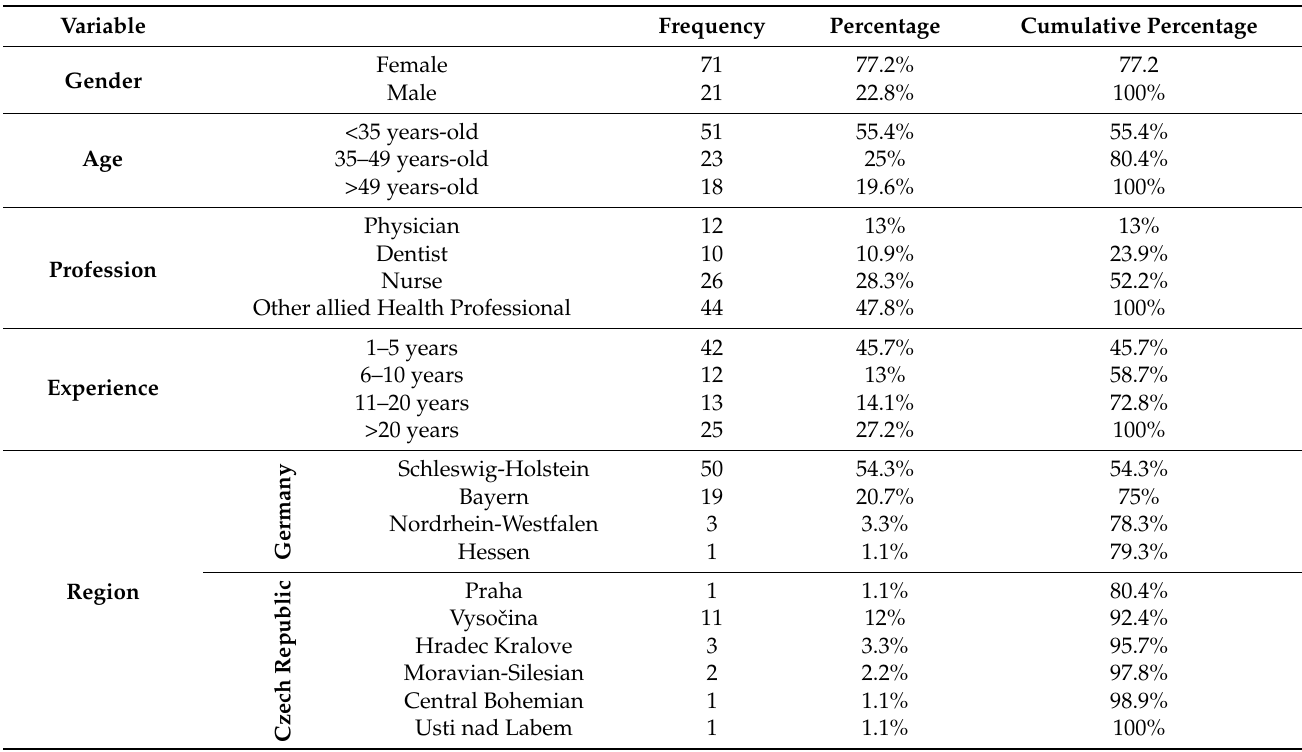
Table 1. Demographic characteristics of European healthcare workers receiving AstraZeneca COVID-19 vaccine, February– March